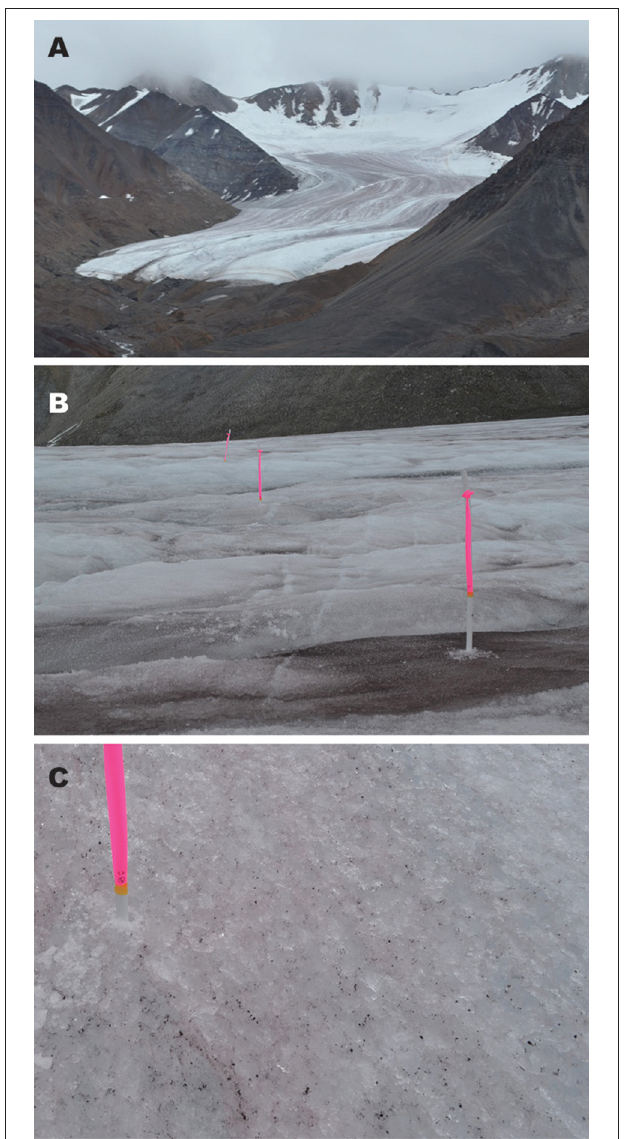
FIGURE 2 | Photographs illustrating (A) Glacier No. 31 in the Suntar-Khayata Range, (B) stakes (No. 15, 16, and 17) installed on ablation surface for measurements of melt, reflectivity, and sampling of impurities, and (C) ice surface of stake No. 7, showing slightly reddish in color due to algal pigment. Diameter of a stake in (C) is approximately 3cm. The photographs were taken on 4 August, 2014.